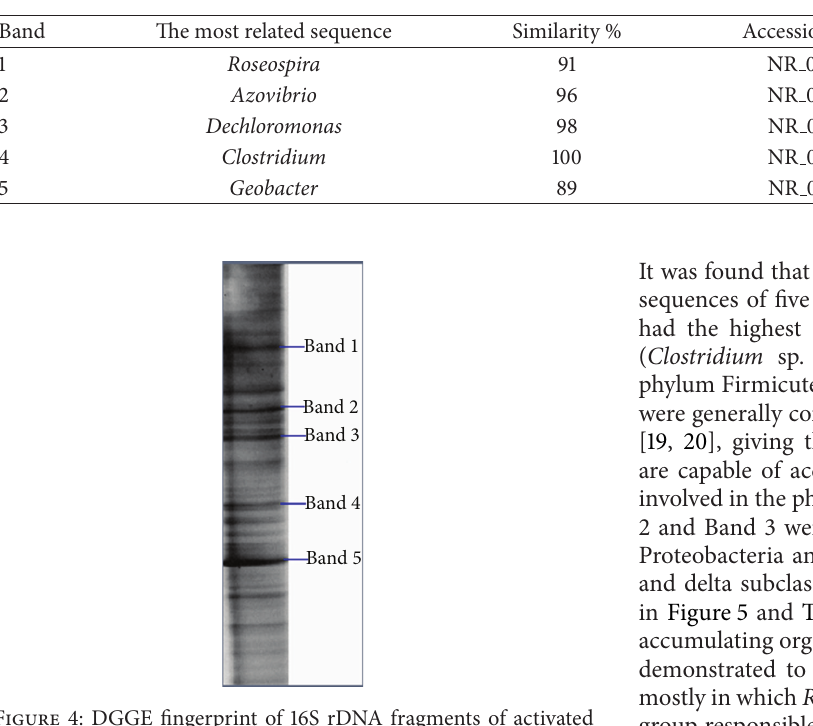
Table 3: NCBI BLAST search results of sequences from DGGE bands.